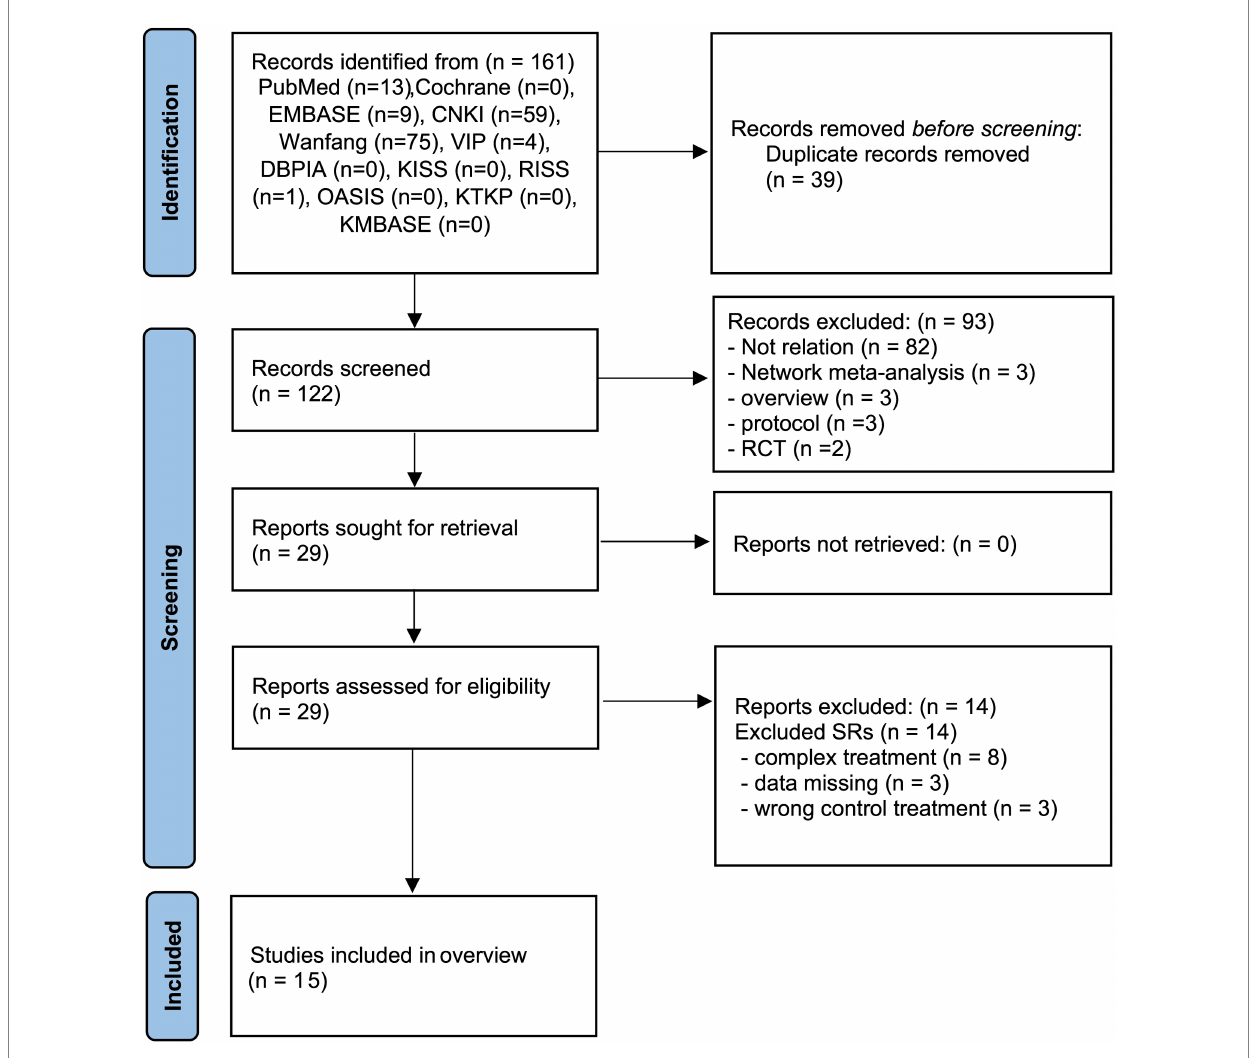
FIGURE 1 PRISMA diagram for the included studies. RCT, randomized controlled trials; SR, systematic